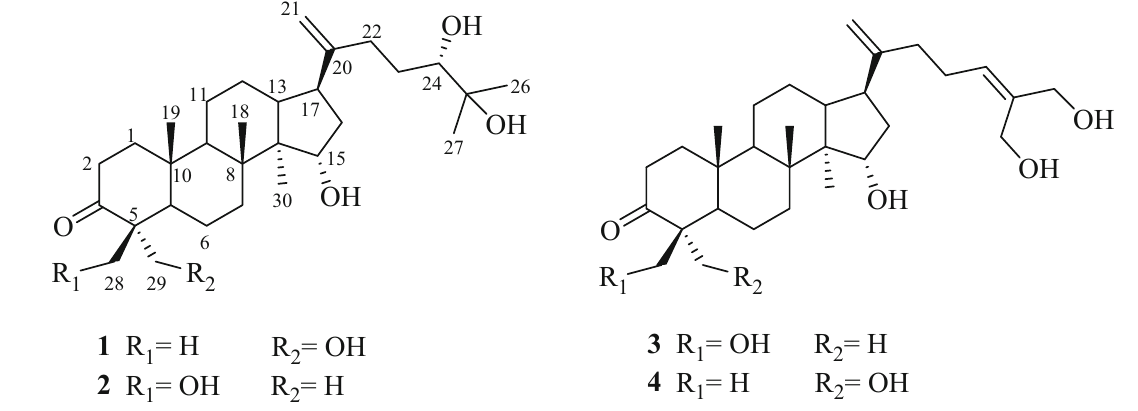
Fig. 1 Structures of caffruones A–D ( 1 – 4 ) isolated from the cherries of Coffea